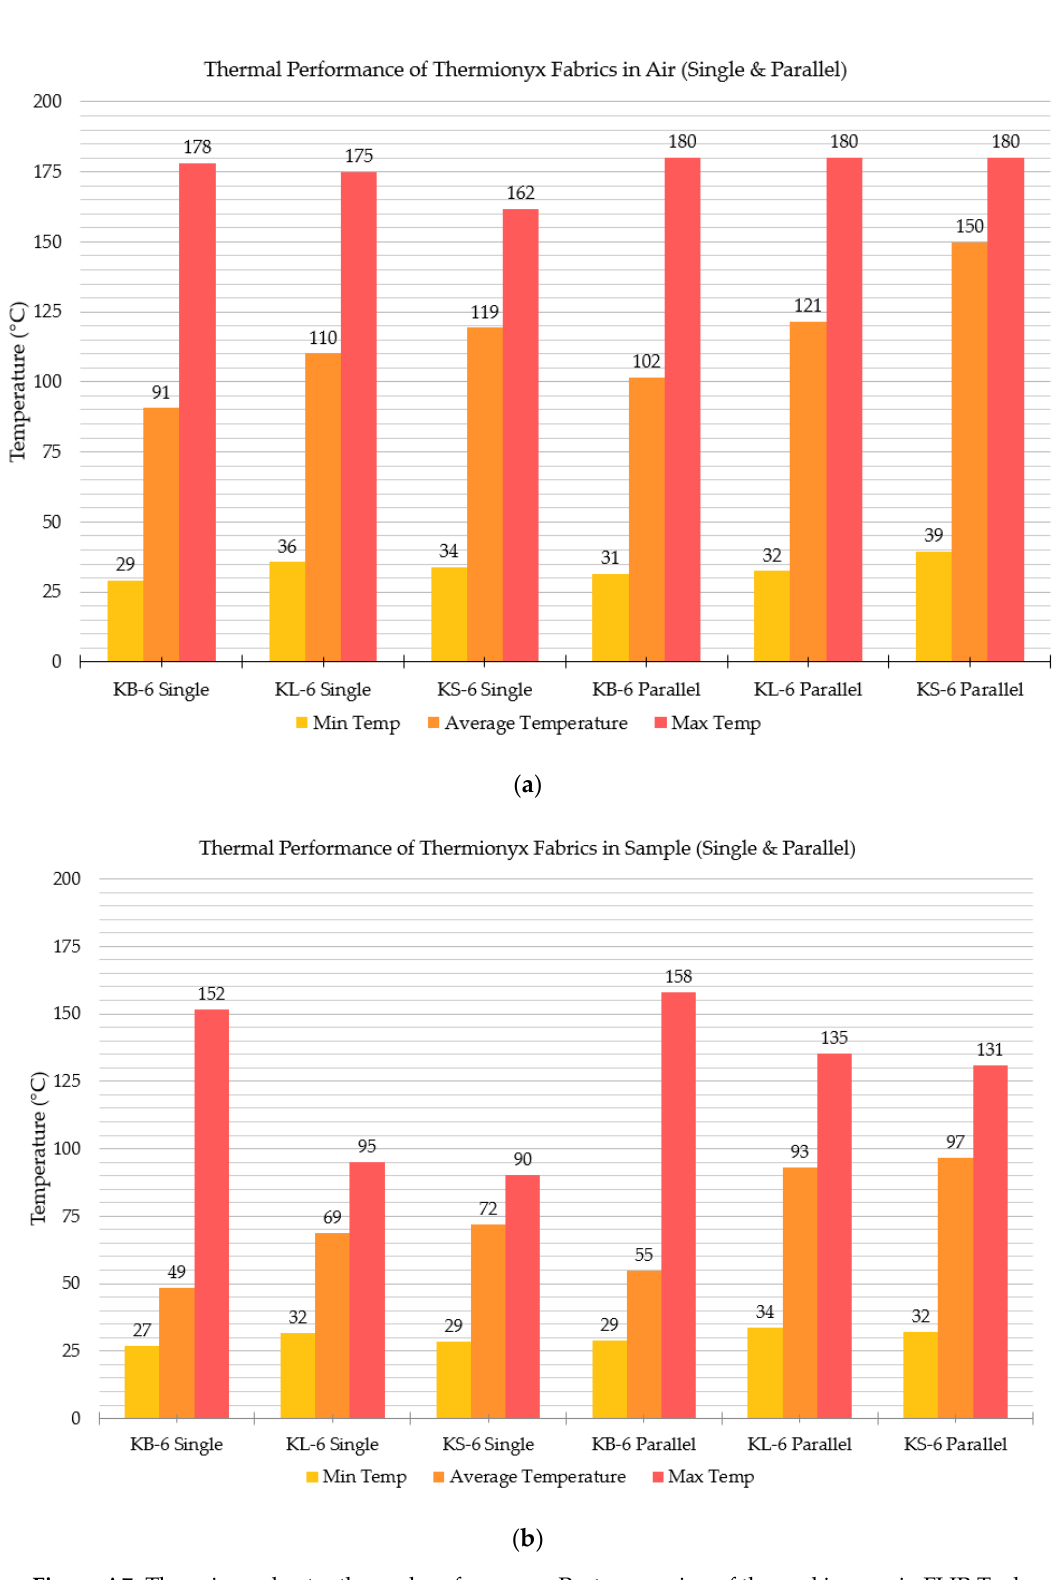
Figure A7. Thermionyx heater thermal performance. Post processing of thermal images in FLIR Tools, conducted on single fabrics and two of the same kind of fabric in parallel. ( a ) Mean temperature range and average temperature of each fabric design in air; ( b ) fabric heaters placed in 70 mm × 50 mm × 10 mm silicone material without ethanol. Temperature readings taken off of surface of silicone.